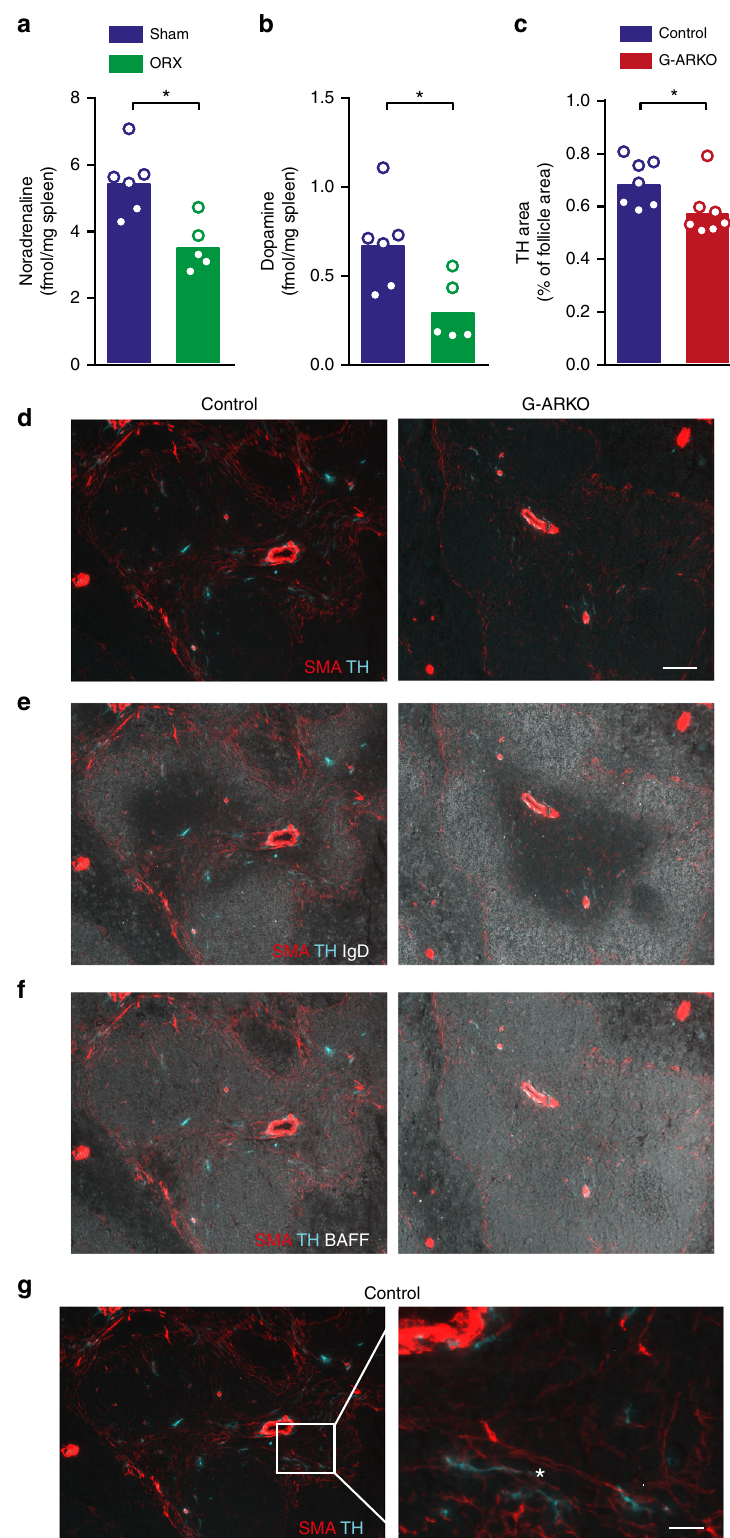
Fig. 4 Testosterone regulates splenic catecholamine levels. a Noradrenaline and b dopamine concentration in spleens of castrated (ORX; n = 6) and sham- operated ( n = 5) male mice. c Quanti fi cation of tyrosine hydroxylase (TH)-stained area in control ( Pgk-Cre + ) and general androgen receptor knockout (G- ARKO) male mice, expressed as percentage of follicle area. n = 7/group. d – f Sections of spleens from control and G-ARKO mice. Turquoise, nerve structures (tyrosine hydroxylase; TH); red, fi broblastic reticular cells (FRCs) and vascular structures (smooth muscle a-actin; SMA). B cells (IgD) are stained white in e and BAFF is stained white in f . Scale bar, 100 μ m. g Higher-magni fi cation image of SMA-positive FRC (red) and TH-stained nerve structures (turquoise); asterisk indicates area of co-localization. Scale bar, 20 μ m. Bars indicate means; circles represent individual mice. * P < 0.05 (Mann – Whitney